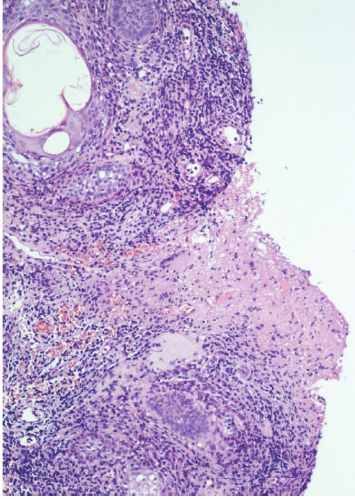
Figure 2: Granulomatous inflammation, Langhans cells, and caseation necrosis